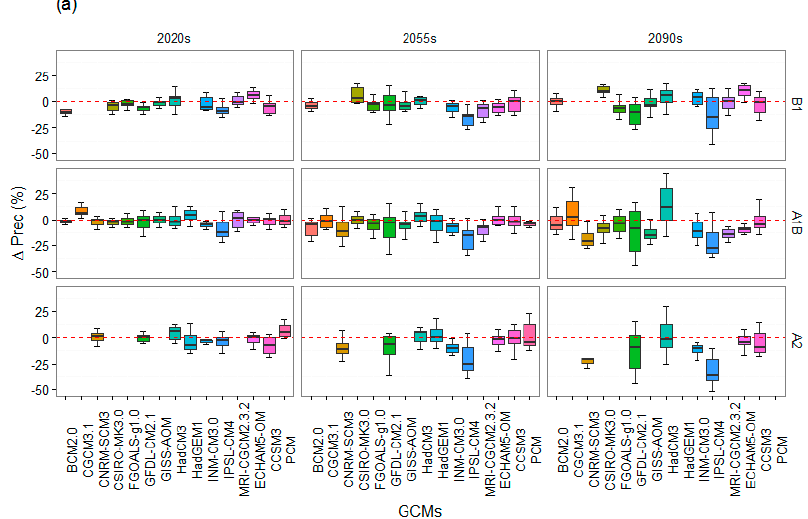
Table 3. Projected annual climate for the Brazos headwaters basin: annual prec. (mm), Tmin (°C), and Tmax (°C) averaged from 15 GCMs simulations across 55 grids. Values between parentheses represent the standard error of the mean